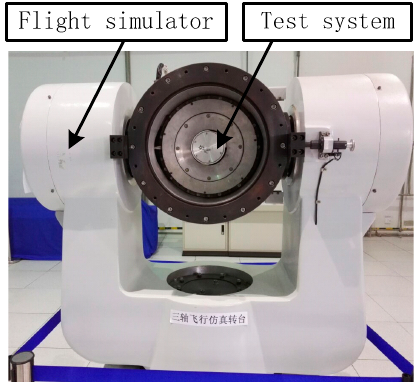
Figure 13. Flight simulator test.